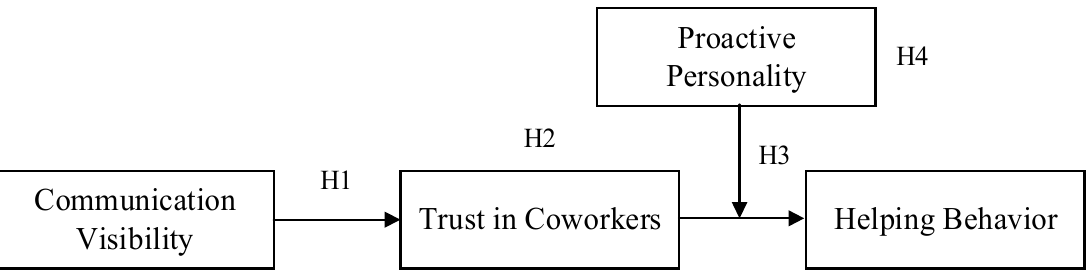
Figure 1. Conceptual model for communication visibility and helping behavior.